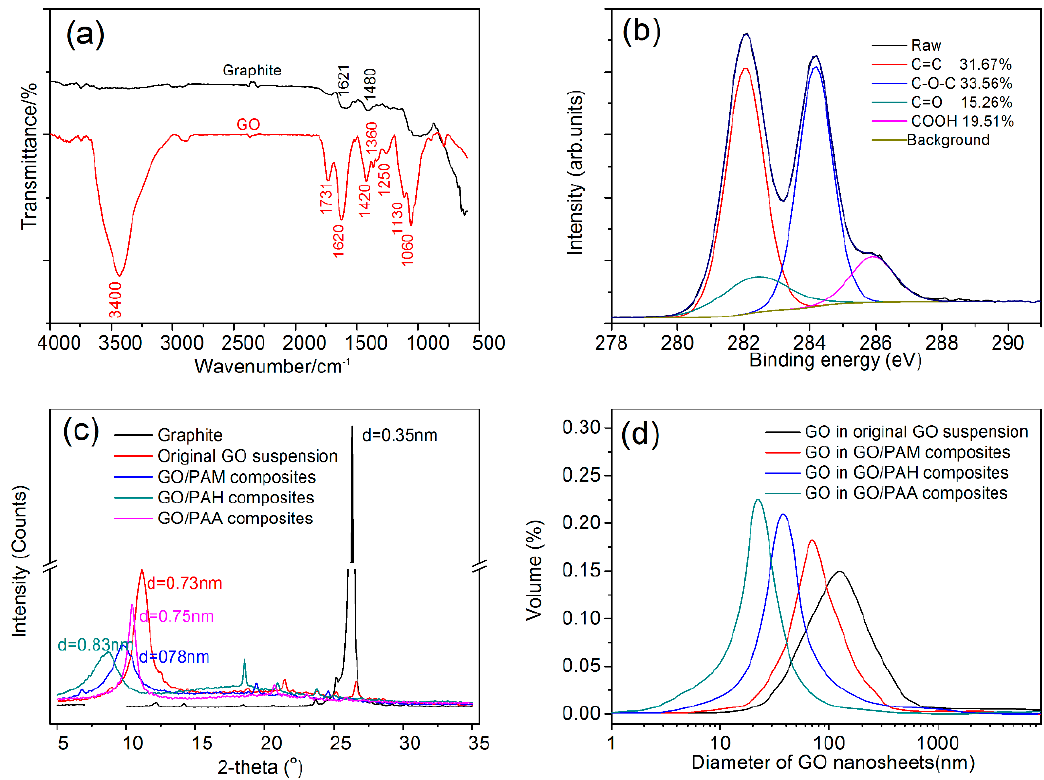
Figure 2. ( a ) FTIR spectra of graphene oxide (GO) and graphite. ( b ) XPS spectrum of GO. ( c ) XRD patterns and ( d ) size distributions of various GO nanosheets.